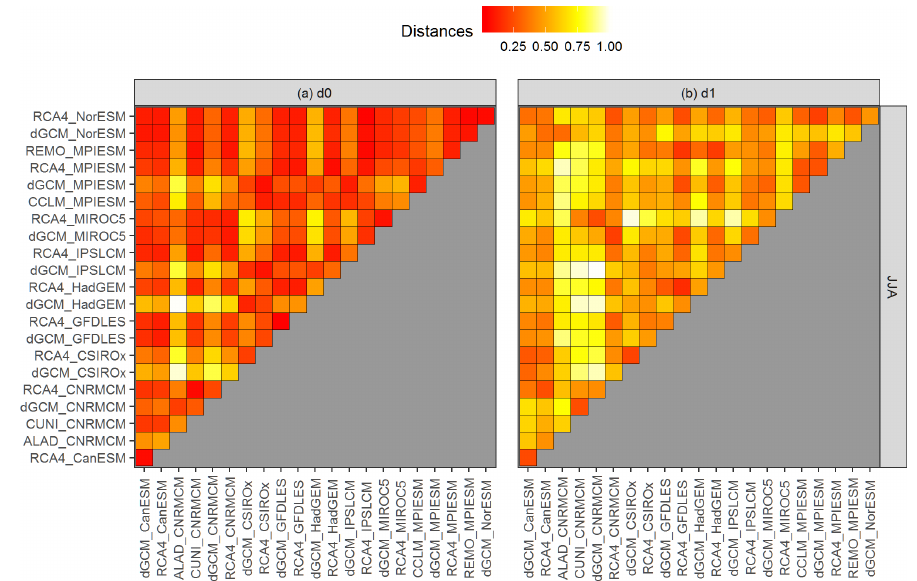
Figure 7. The same as Fig. 6, but for running 30-year mean relative changes in summer (JJA) mean precipitation over eastern European region (the curves are shown in Fig. 2b, underlying data are shown in Fig.